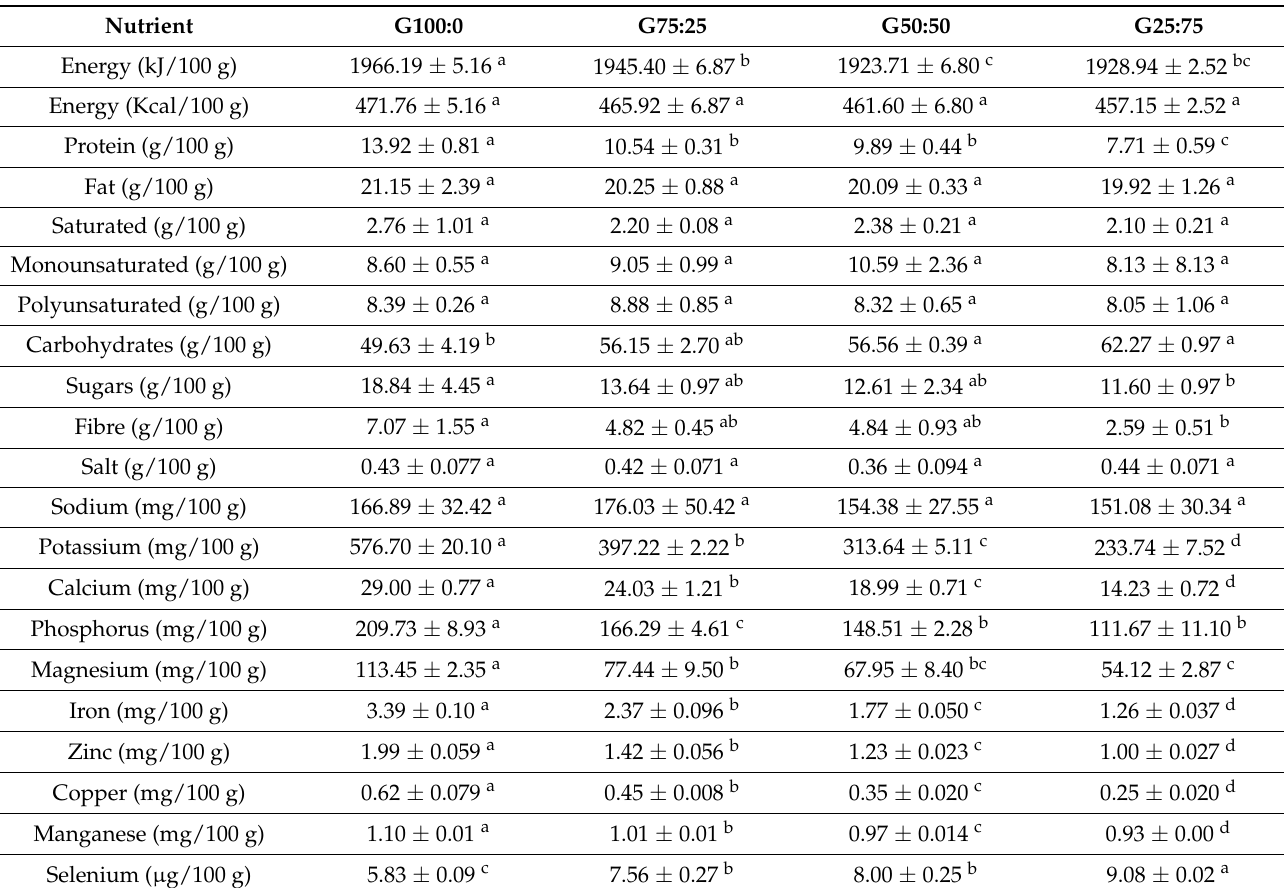
Table 4. Nutritional composition of the four biscuits (mean value of 3 measurements and standard deviation are shown). G100:0 = 100% CF/0% RF; G75:25 = 75% CF/25% RF; G50:50 = 50%